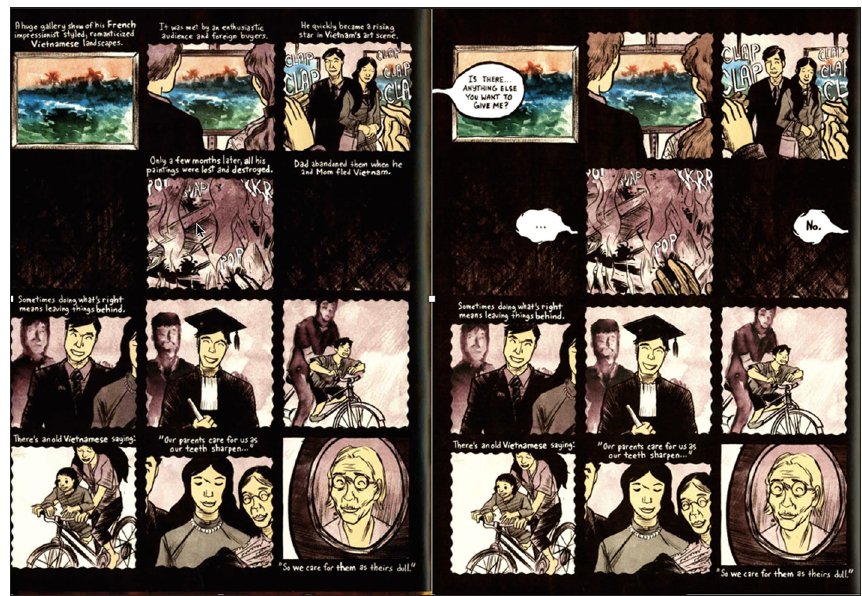
Figure 2: Tran, GB (2010) Vietnamerica (London: Villard, 24 and 200)  Gia-Bao